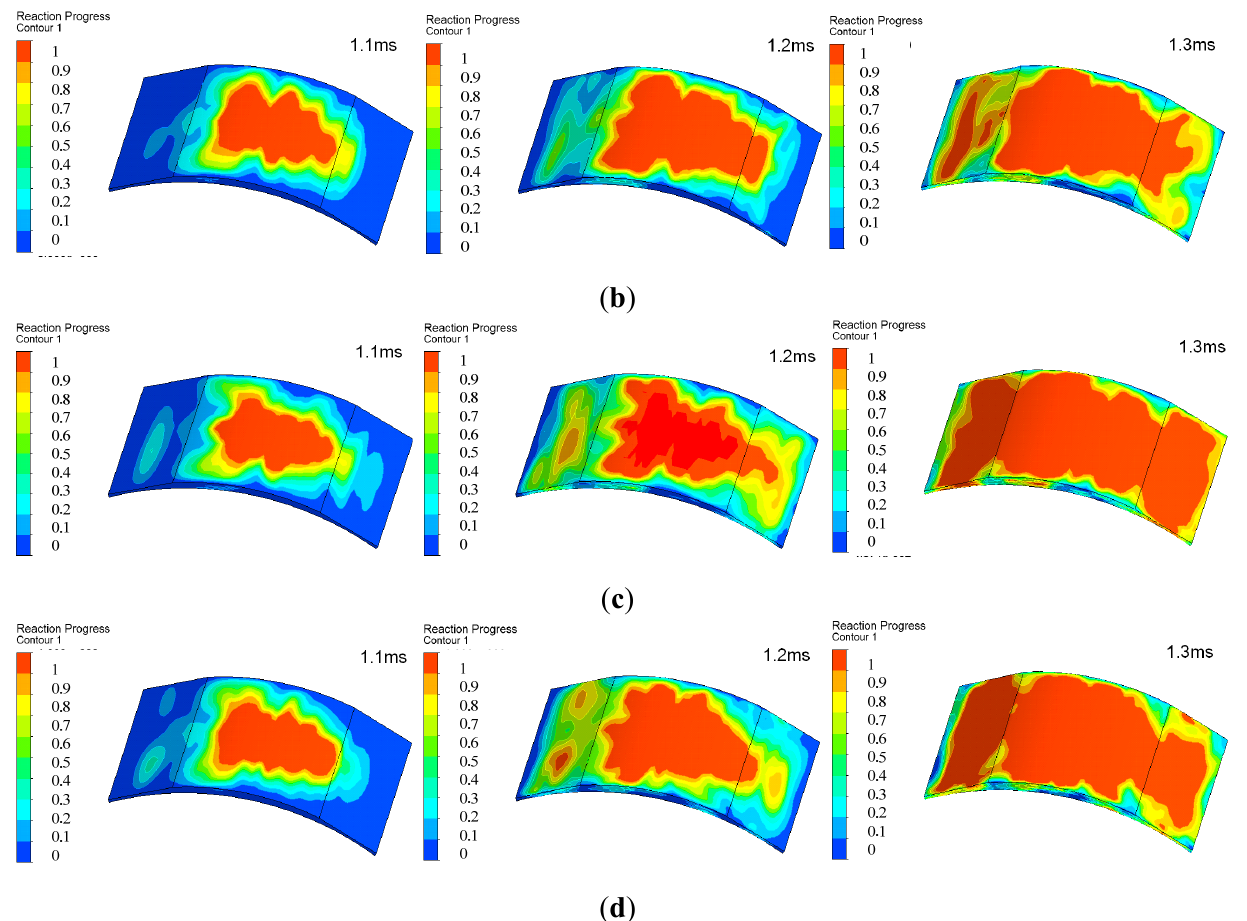
Figure 11. ( a ) Reaction process at pressure 1.37 MPa; ( b ) Reaction process at pressure 1.42 MPa; ( c ) Reaction process at pressure 1.47 MPa; ( d ) Reaction process at pressure 1.52